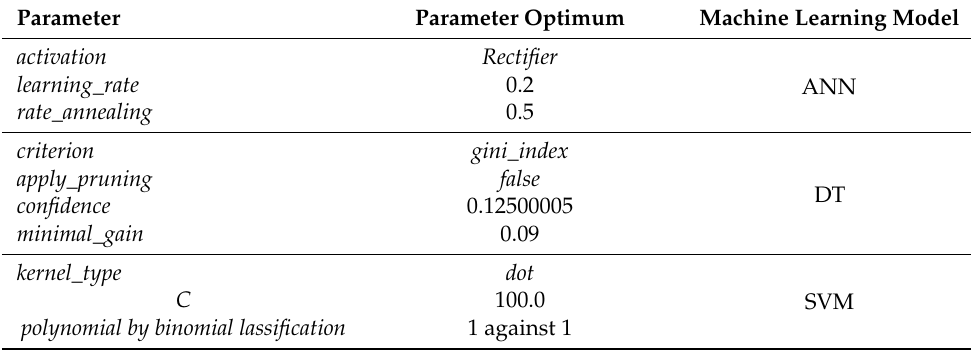
Table 8. Parameter setting results for the ANN, DT, and SVM